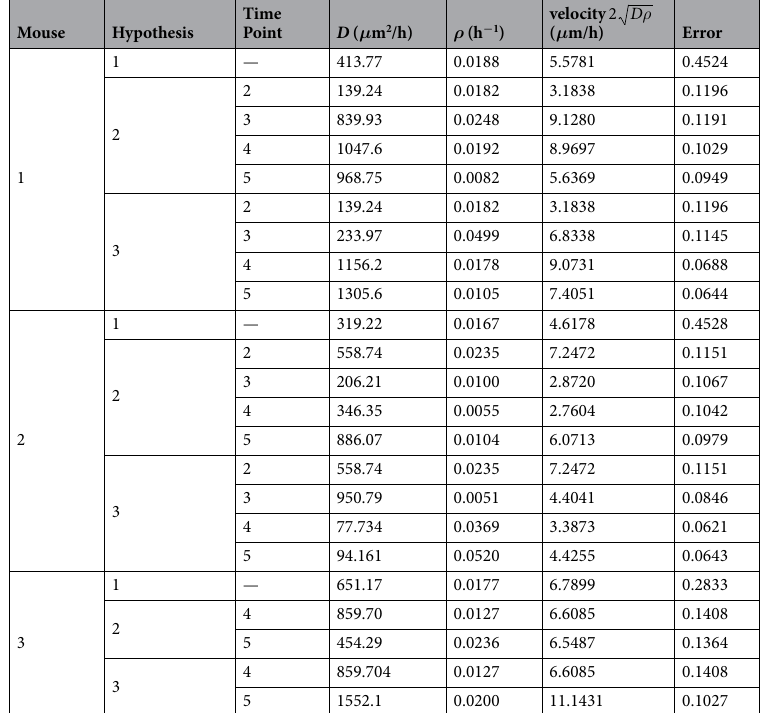
Table 2. Values of estimated parameters for Mouse 1, 2, and 3 and each hypothesis at each time point using the 3D finite difference method. Minimization is performed with respect to equation